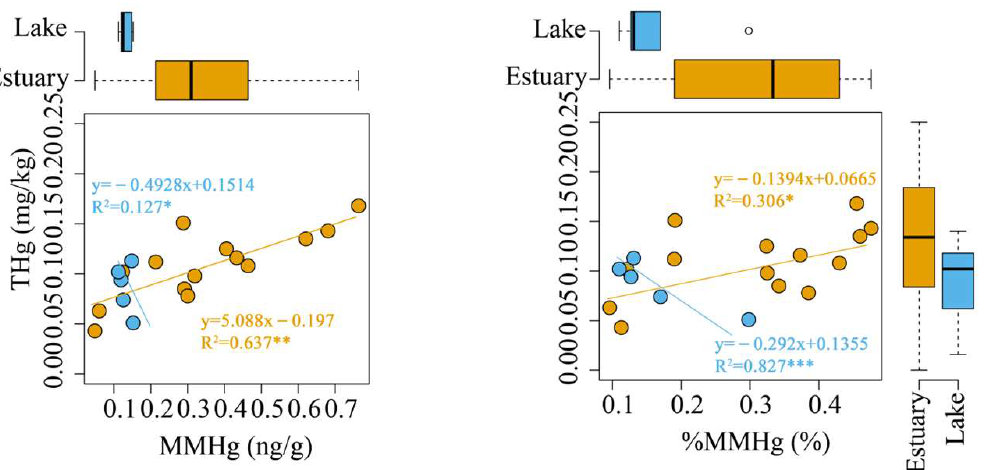
Figure 6. Correlation between THg with MMHg and %MMHg. Blue dots represent sampling sites for lakes, while yellow dots represent sampling sites for estuaries. The box chart represents the concentration range of various substances in the lake or estuary, the lines in the box represent the average value, the bottom and top of the box represent the 25th and 75th percentile quantile, and the short lines at both ends represent the maximum and minimum values. * represented significant level p < 0.05, ** represented significant level p < 0.01, and *** represented significant level p < 0.001.